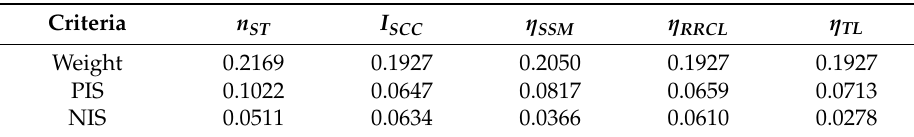
Table 5. Weight of criteria, PIS and NIS in Case 1.